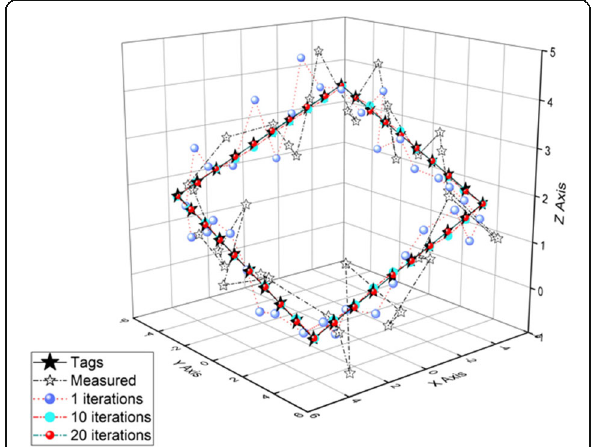
Fig. 15 Results of the three kinds of iteration times for 3D indoor localization. We illustrate the optimized position for each target after three kinds of iteration times, which is denoted by different color dots. It can be found that the locations are approaching optimal after 20 iterations; the ELPSO algorithm converges